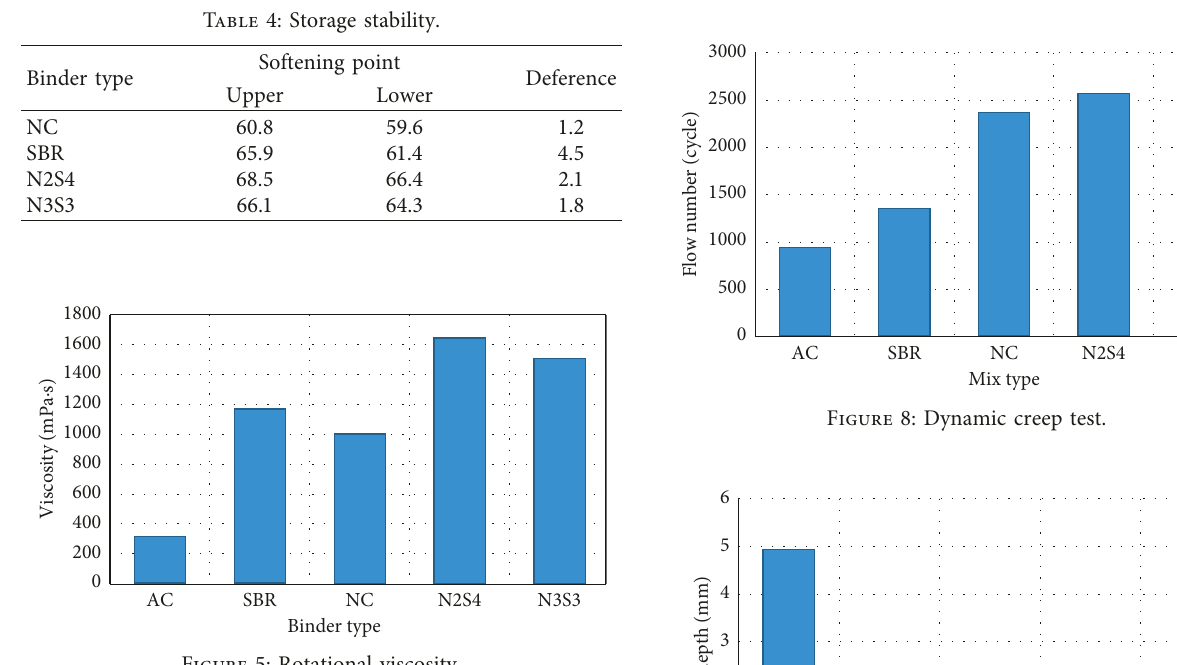
Figure 5: Rotational viscosity.